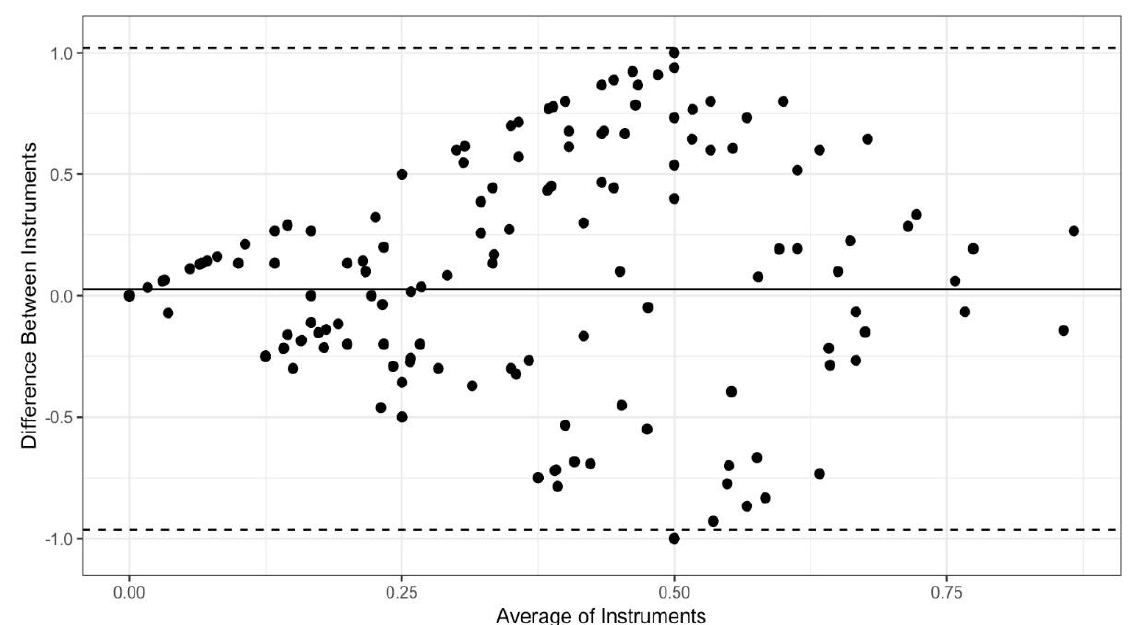
Figure 3. Bland-Altman plot for the PTCL and the PSPQ. Solid horizontal line represents the mean difference between instruments (the PTCL minus the PSPQ); dashed lines represent the 95% CI of differences.